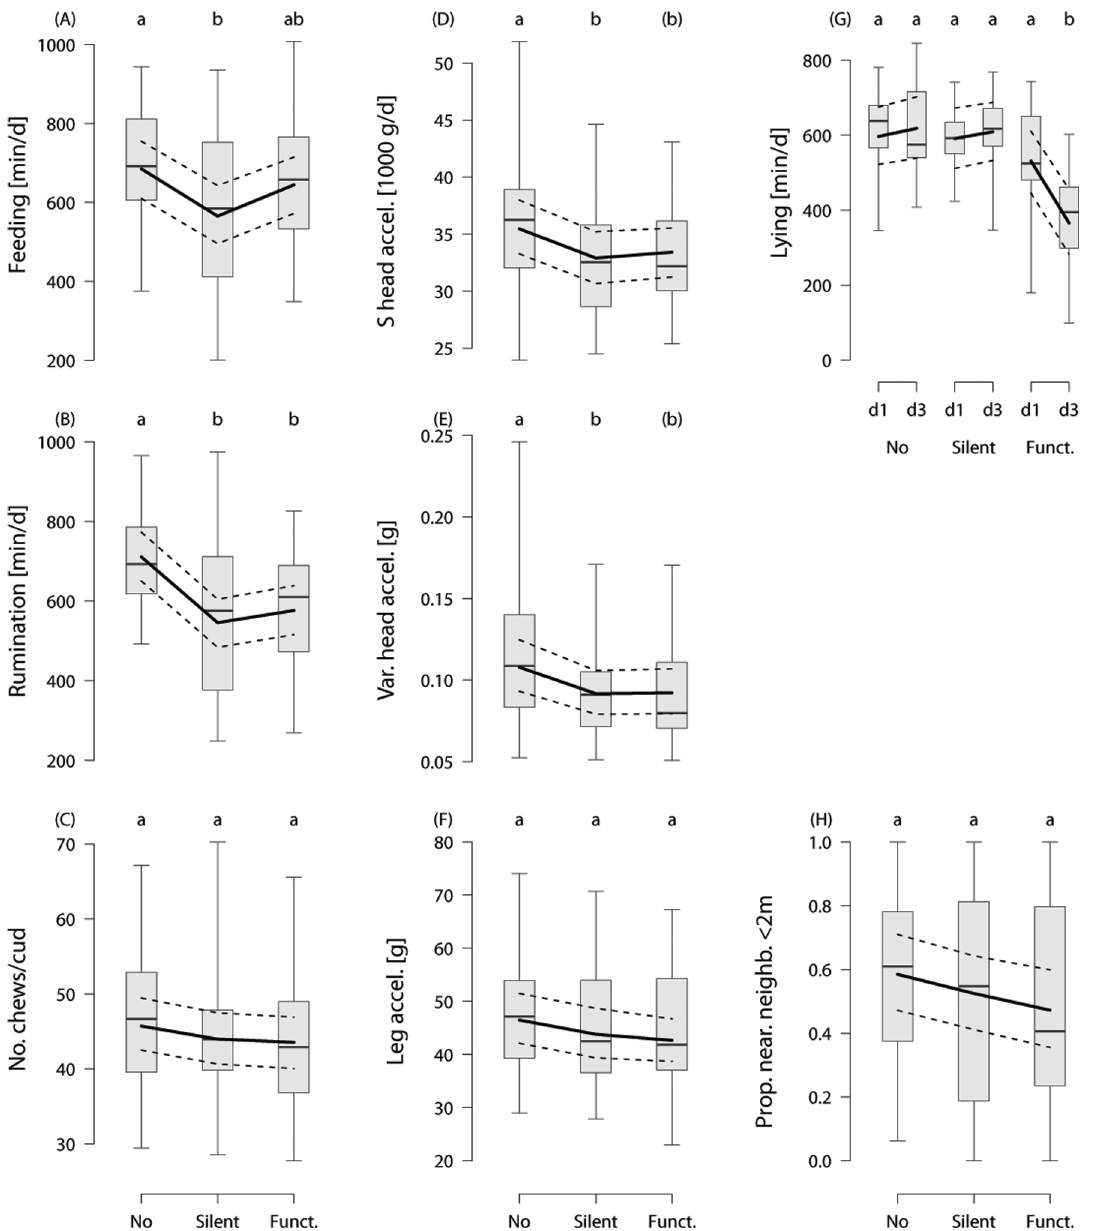
Fig 3. Effects of bells on the behaviour of dairy cows on pasture. A. Feeding duration per 24 hours [min], B. Duration of rumination depending on the treatment [min], C. Number of chews per rumination cud, D. Summed changes in head acceleration per 24 hours [ g ], E. Variance in head acceleration changes per 24 hours [ g ], F. Changes in leg acceleration during standing bouts [ g ] depending on the treatment, G. Lying duration per 24 hours [min] depending on the treatment and the day of observation, H. Proportion of scans with the distance to the nearest neighbour < 2 m depending on the treatment. Raw data are presented as box plots indicating observed median, first and third quartiles and absolute range of data. The solid lines show the model estimation, the dashed lines the 95% intervals of confidence. Different letters reflect significant differences ( p (cid:2) 0.05) and letters in parentheses p < 0.1 from the Tukey corrected post-hoc